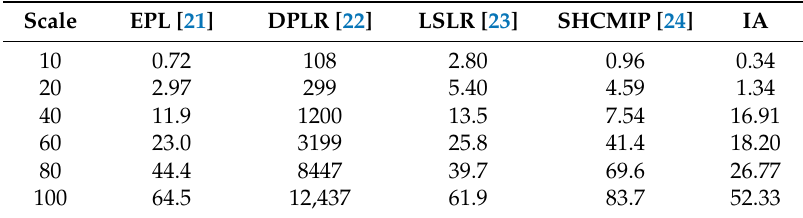
Table 5. Comparison of computing time between different algorithms (s).